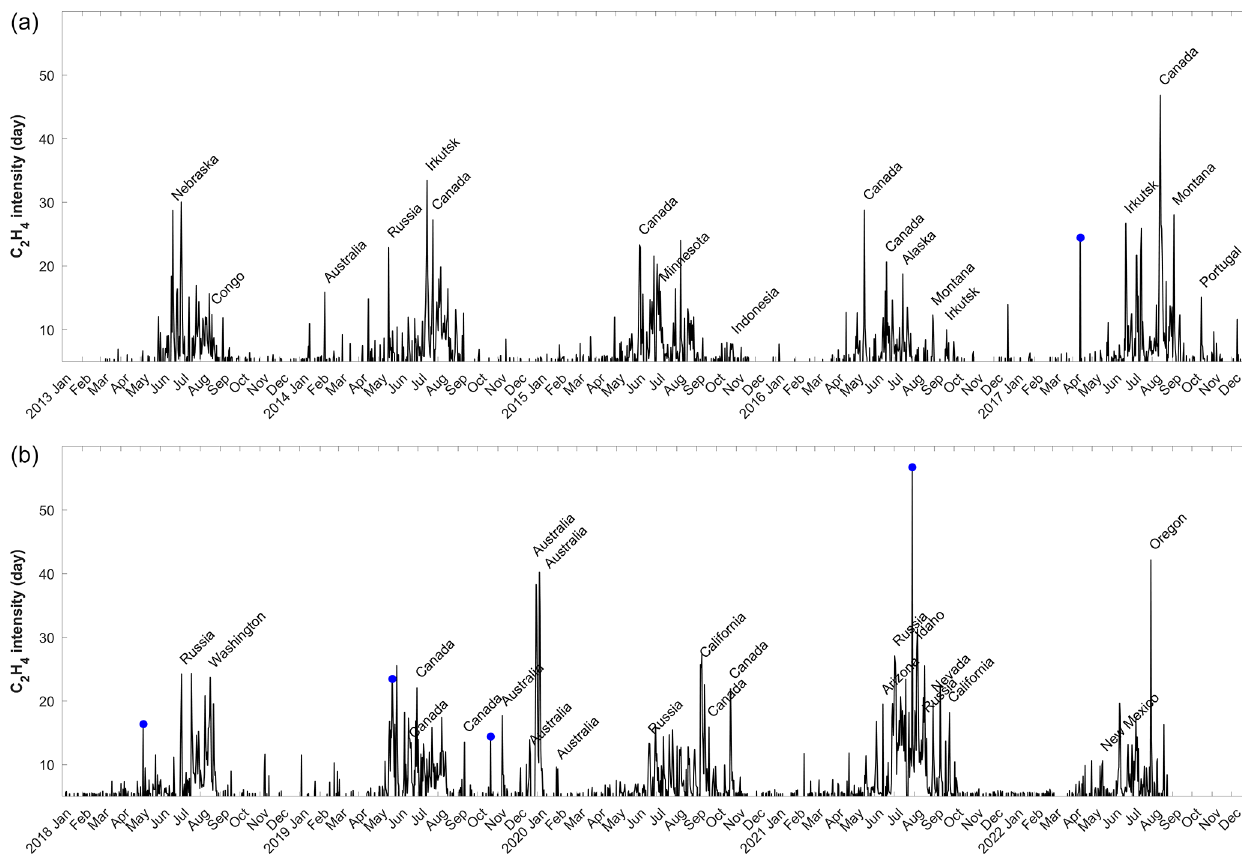
Figure 10. Time series of C 2 H 4 detections from the IASI-PCA-GE method based on the IASI/Metop-B L1C data for the 2013–2022 period. Only the daily extrema are shown in the time series. For clarity, the time series are separated into two periods, namely 2013–2017 (a) and 2018–2022 (b) . Some events (blue dots) are associated with sporadic industrial